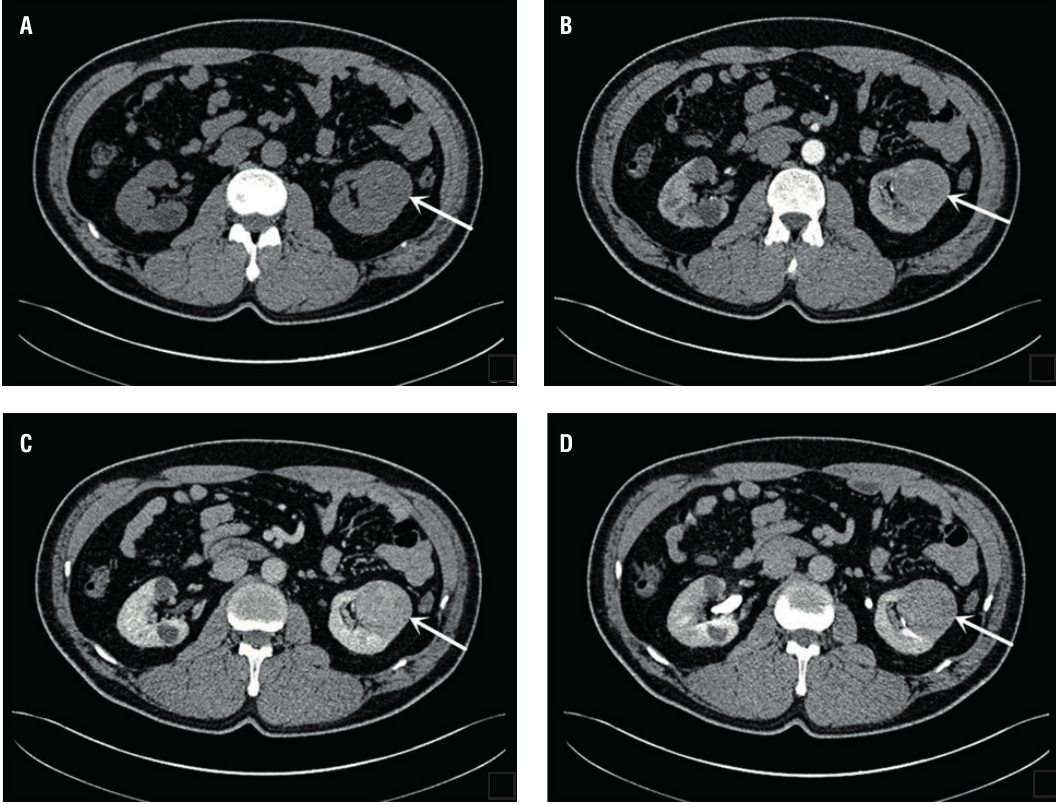
figure 1 (A-D) Lesion is well-circumscribed and homogeneous on unenhanced (A), arterial (B), venous (c), and delayed (D) images, respectively.